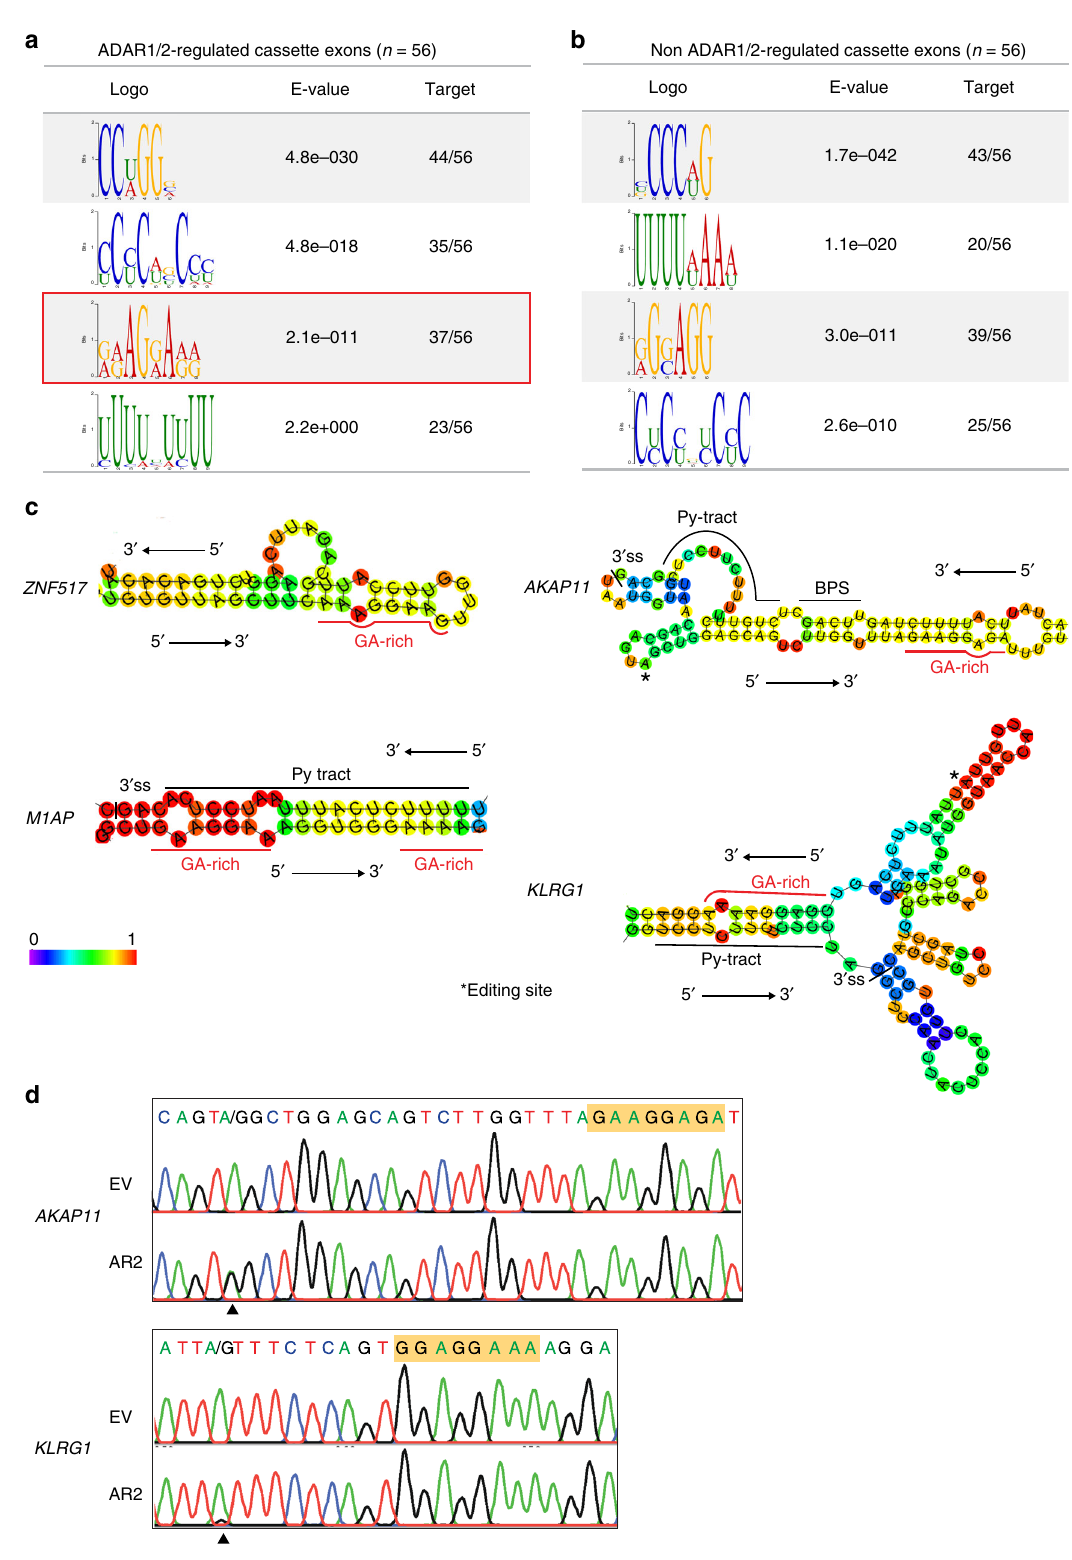
Fig. 6 Involvement of GA-rich motif(s) in ADARs-mediated splicing regulation. a , b The top four motifs enriched in ADARs-regulated cassette exons a and non-ADARs-regulated cassette exons b as provided by MEME. Height of letter depicts occurrence of nucleotides at speci fi c position. E -value represents statistical signi fi cance of the motif. Target represents the number of cassette exons containing a particular motif over total input number. c RNA secondary structure predictions for pre-mRNA sequences of representative ADARs-regulated cassette exons by RNAfold. Base-pair probabilities are shown by a color spectrum. Red line indicates the GA-rich motif. Asterisk denotes editing site. d Sequence chromatograms illustrate editing site adjacent to GA-rich motif of AKAP11 and KLRG1 upon ADAR2 overexpression in HEK293T cells. GA-rich motif is shaded in orange. Black arrowhead indicates editing